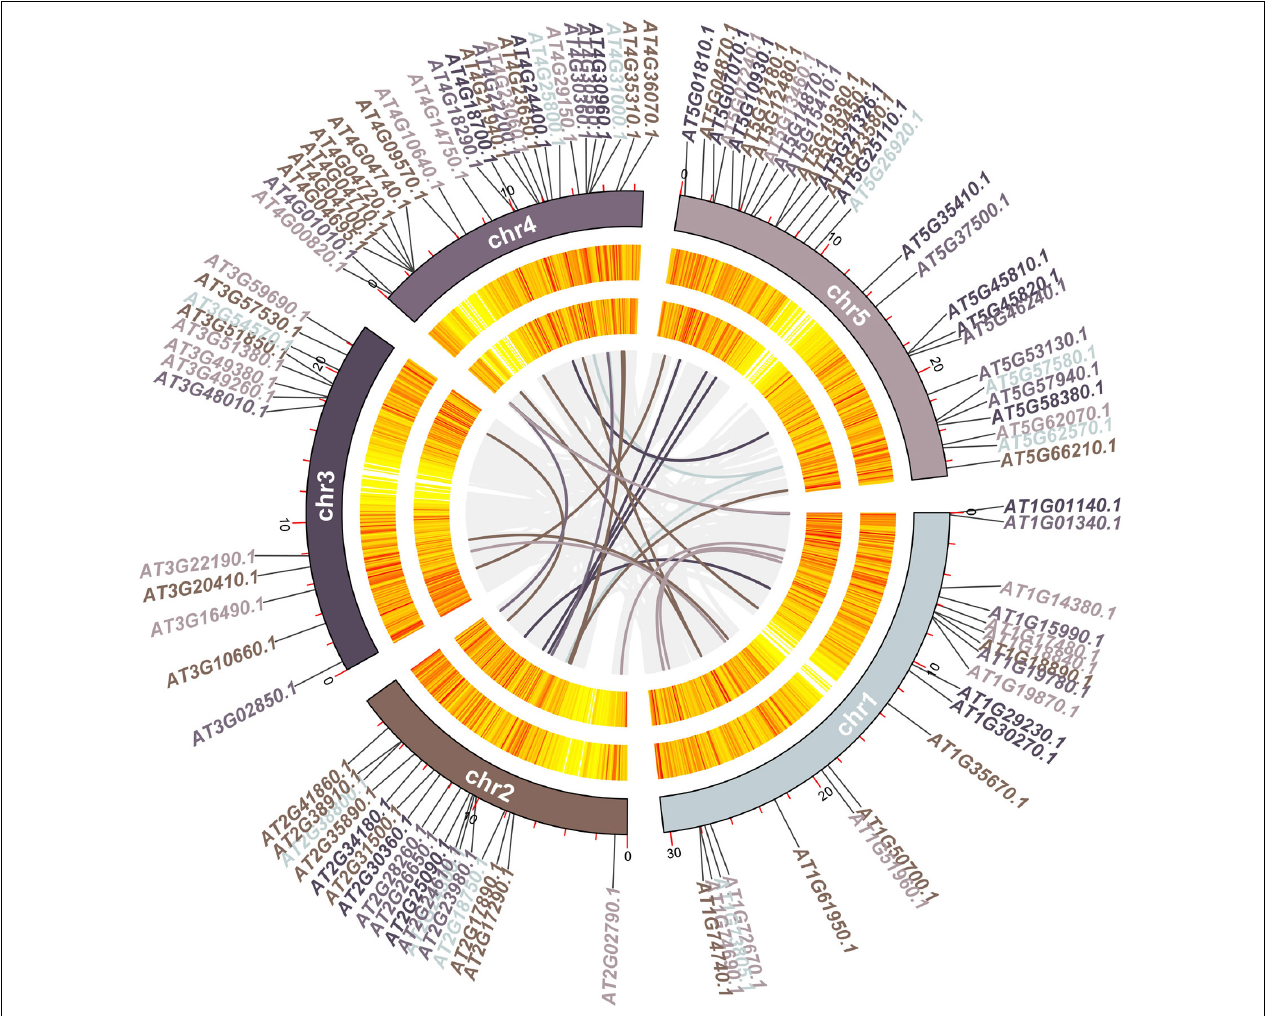
FIGURE 5 | Circos diagram of the 102 genes in calcium-related gene families. Chromosome numbers are provided on each chromosome. The lines in different colors indicate the gene pairs of the 102 genes in calcium-related gene families.